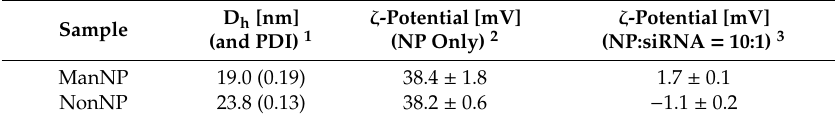
Table 1. Characterization data of α -mannosylated and non-mannosylated cationic nanohydrogel particles [23].